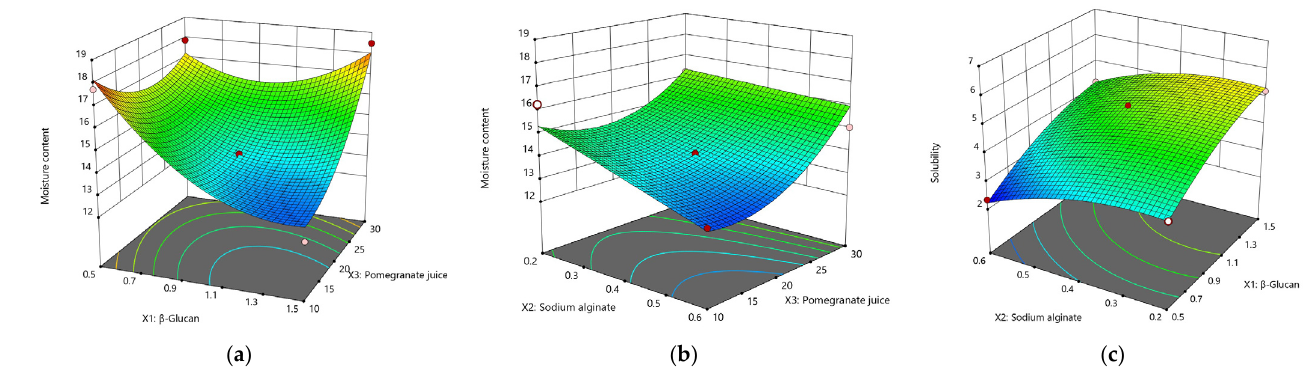
Figure 3. 3-D surface plots for the effect of independent variables on the film moisture content and solubility. ( a ) Effect of β –glucan and PJ on MC; ( b ) Effect of SA and PJ on MC; ( c ) Effect of SA and β –glucan on the solubilization time. β –glucan on the solubilization